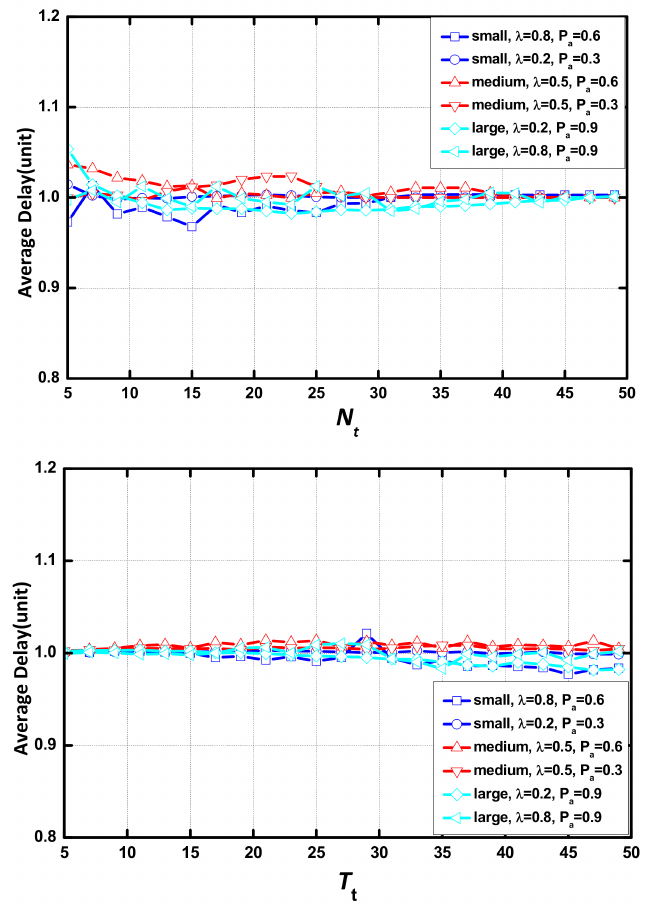
Figure 15. Ratio of the number of aggregations vs. N t or T t